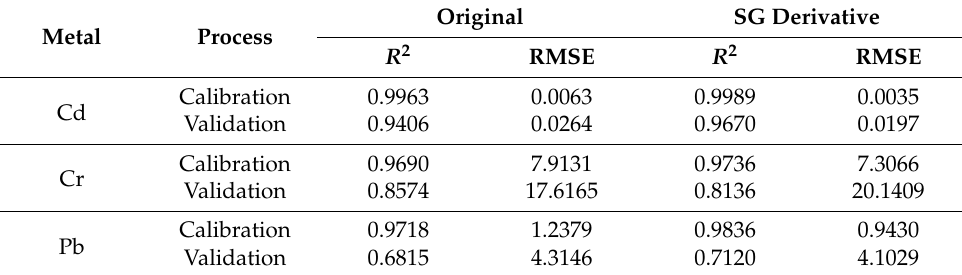
Table 2. The calibration and validation performance of the PLSR